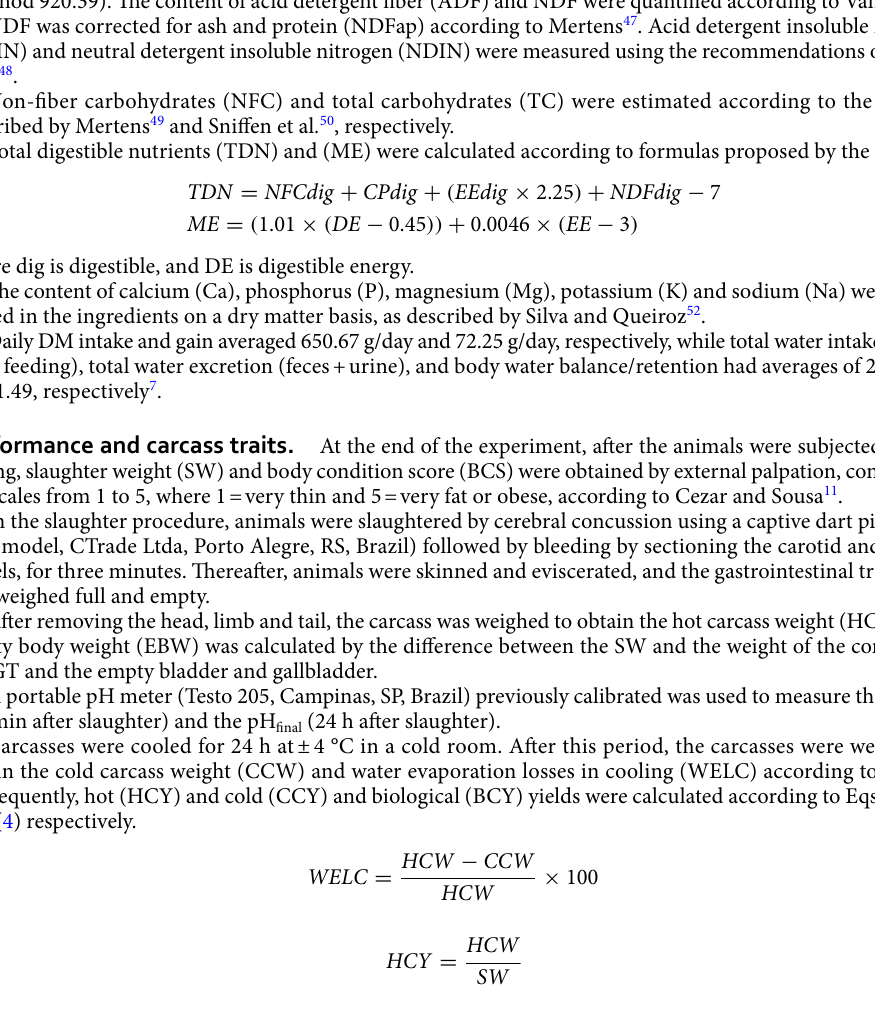
The methods proposed by AOAC 45 were used to determine the concentrations of dry matter (DM, method 934.01), crude protein (CP, method 954.01), ether extract (EE, method 920.39), ash (method 942.05) and lignin (method 920.39). The content of acid detergent fiber (ADF) and NDF were quantified according to Van Soest 46 . NDF was corrected for ash and protein (NDFap) according to Mertens 47 . Acid detergent insoluble nitrogen